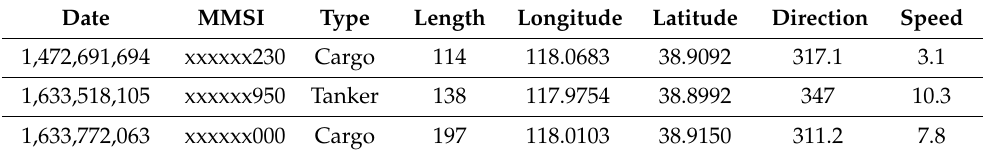
Table 1. Example of AIS sample